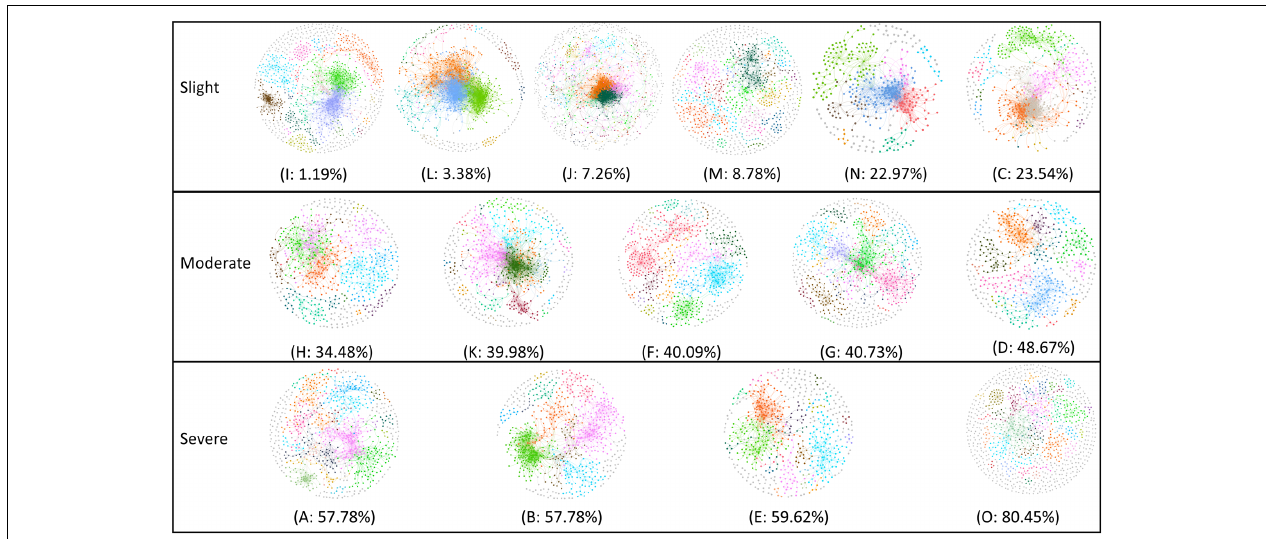
FIGURE 4 | Random matrix theory (RMT)-based molecular ecology networks in soils during Tobacco cultivation. Networks are present following the order of Tobacco bacterial wilt infection rate (from low to high). In the networks, nodes represent OTU and links represent significant correlation, modules are randomly colored and modules with less than five nodes are colored gray. Sites with relative low infection rate ( < 25%, including I, L, J, M, N, and C) were referred to ‘healthy’ group, sites with relative high infection rate ( > 50%, including H, A, B, E) were referred to ‘severe’ group and others that has the infection rate between 25 and 50% (K, F, G, O and D) were referred to ‘moderate’